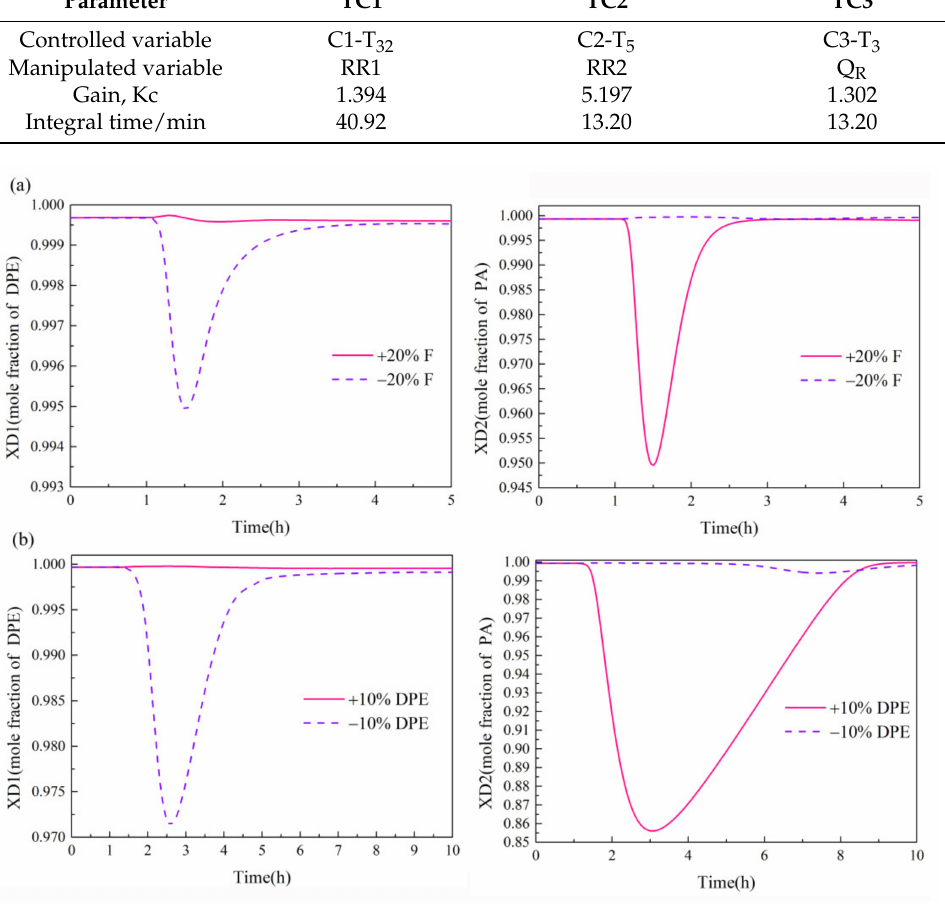
Figure 11. Dynamics responses of CS1 ( a ) 20% feed flow rate disturbances, ( b ) 10% feed composition